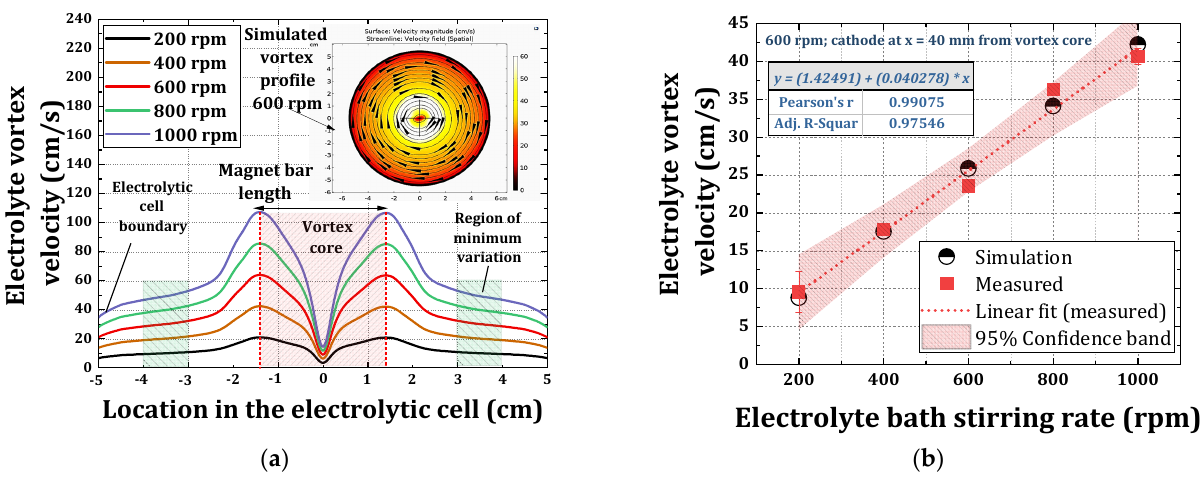
Figure 2. ( a ) Simulated 2D cross-sectional profile of the electrolyte vortex flow along the electrolytic cell, realized by a magnetic stirrer at varying bath stirring rates (inset shows the 2D simulated profile for 600 rpm, with top-view perspective of cell); ( b ) Simulated and measured electrolytic vortex velocity in stirred NiCo electrolyte as a function of varying bath stirring rates taken at distance of 40 mm (i.e., x = 40 mm) away from the vortex core.